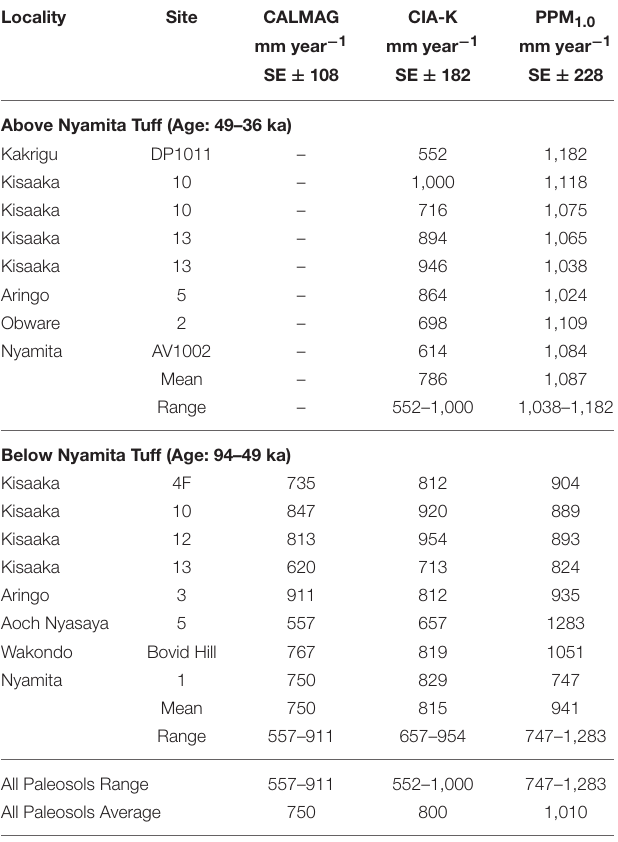
TABLE 3 | Pleistocene paleosol mean annual precipitation